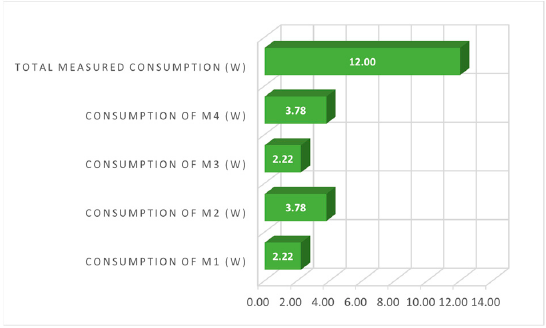
Figure 43. Power consumption—measured in the case of the four-wheeled robot. The cumulated information about current and power absorbed at the level of servomotors and mobile robots (simulated and measured) along with the errors are presented in Table 12. It was found that the relative error of the total consumed power determined after the simulation is 2.2%. Table 12. Current and power consumption values of the motors and of the entire mobile robot with four drive wheels.